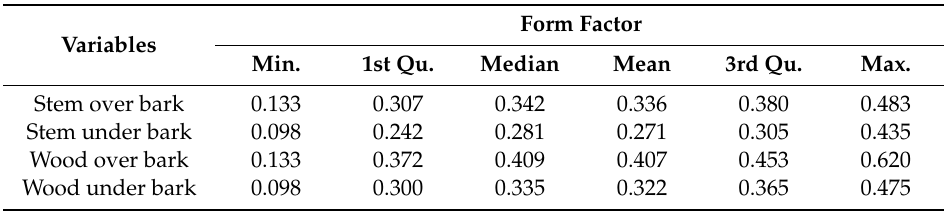
Table 2. Form factor over and under bark for the Shorea robusta